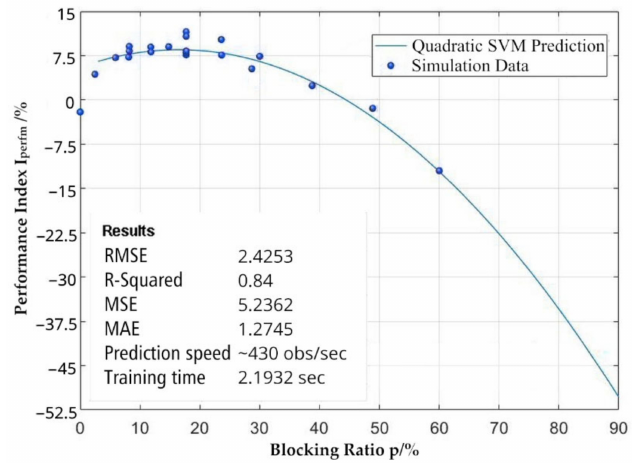
Figure 18. Prediction of the influence of blocking ratio on I perfm of side wing with SVM re- gression model using quadratic kernel function, trained on the dataset with 20 simulation cases mentioned